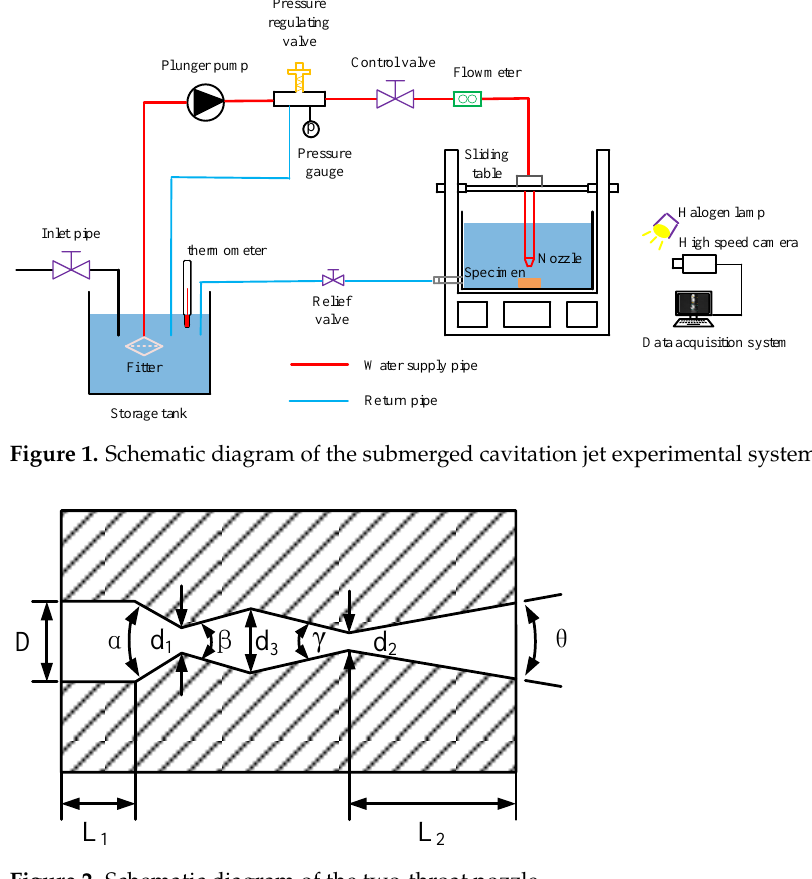
Figure 2. Schematic diagram of the two-throat nozzle. Table 1. Structural parameters of the two-throat nozzle.